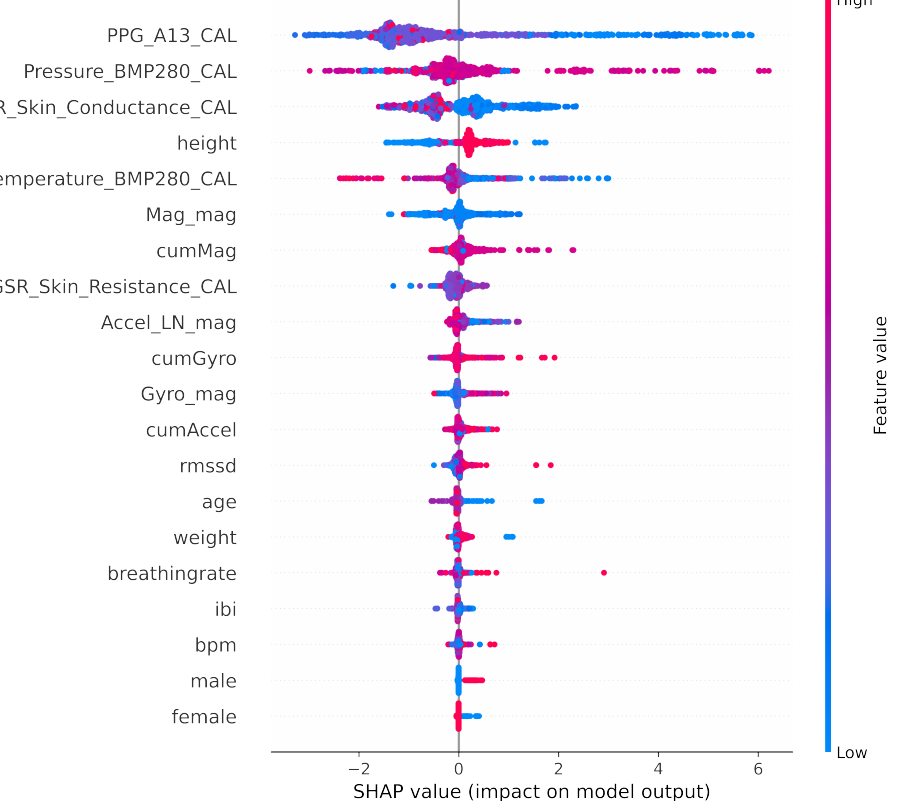
Figure 9. Shapley values for the random forest model using SHAP to show the impact of each feature on the model output (please refer to Table 2 for the meaning of the